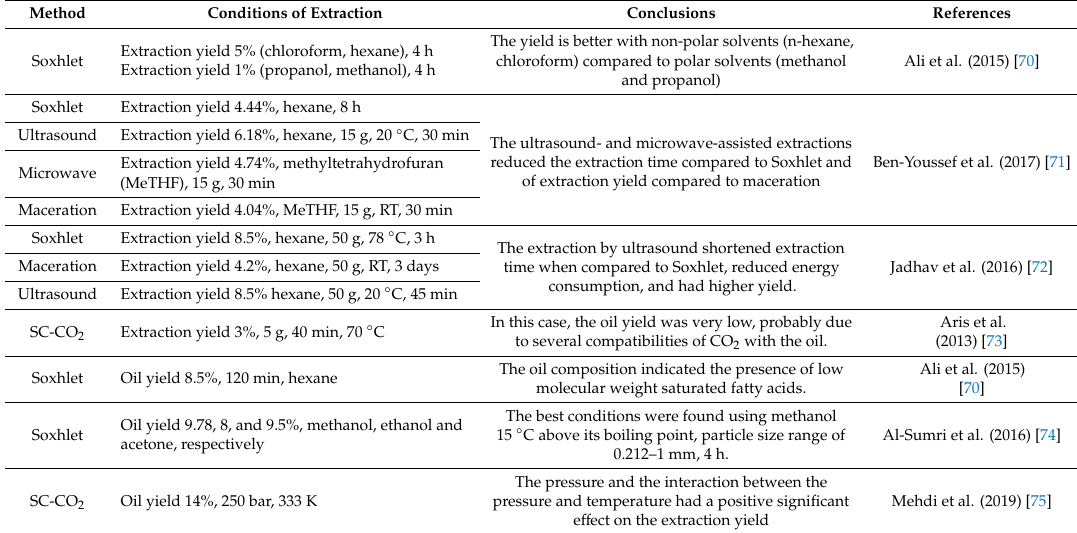
Table 3. Date seed oil recovery based on extraction